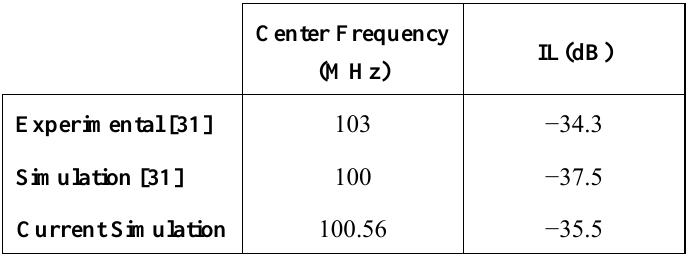
Table 3. Comparing current simulation results with results published in the literature.